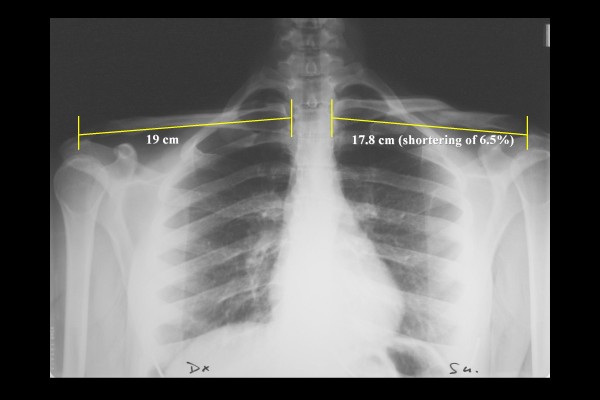
Radiographic image of the clavicle of a satisfied patient after conservative treatment of a diaphyseal clavicle fracture. The observed shortening was 12 mm, or 6.5%; the Constant score was 80.